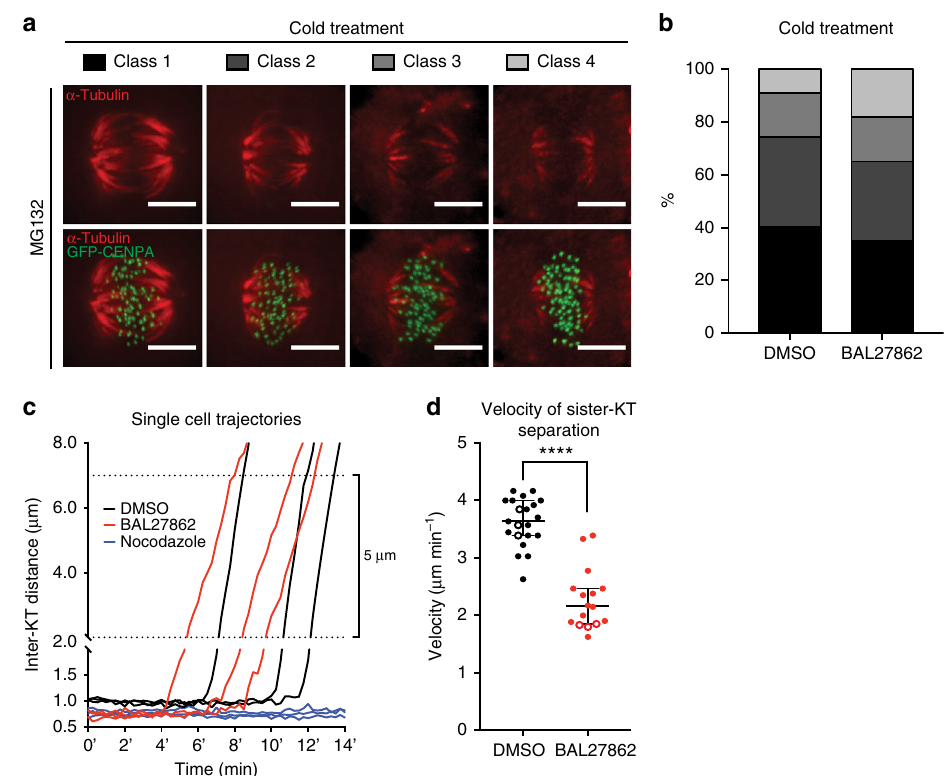
Fig. 7 Complete KT – MT occupancy ensures robust anaphase forces. a , b Cold stable assay in hTert-RPE1 GFP-CENPA cells treated with DMSO or 12 nM BAL27862 and stained for α -tubulin. b Quanti fi cation of the cold stable assay. N = 3, n = 89 – 102 cells. c Exemplary curves of average sister-KT distances in anaphase in hTert-RPE1 GFP-CENPA cells treated with DMSO (black), 12 nM BAL27862 (red) or 1 μ g ml − 1 nocodazole (negative control; blue). T = 0 indicates the start of the movies. d Dot plot of anaphase speeds in hTert-RPE1 GFP-CENPA cells treated with DMSO or 12 nM BAL27862; empty dots are cells represented in c ; N = 3, n = 16 – 21, error bars show 95% CI of medians, **** represents p < 0.0001 in two-tailed t